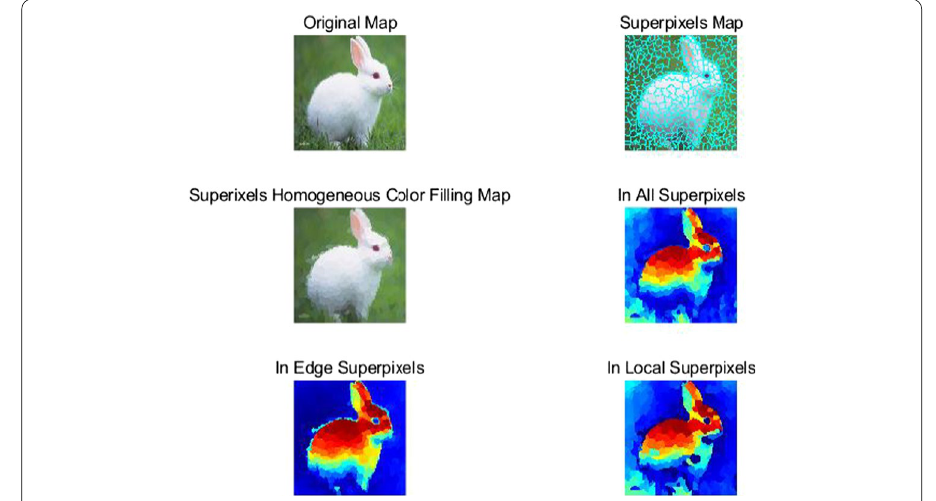
Fig. 4 Saliency detection diagram of LVA algorithm